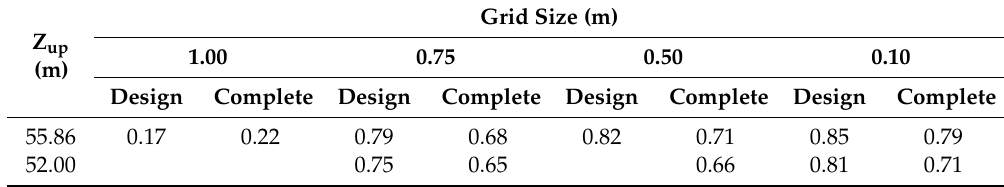
Table 4. Nash coe ffi cient of velocity. Table 4. Nash coefficient of velocity.